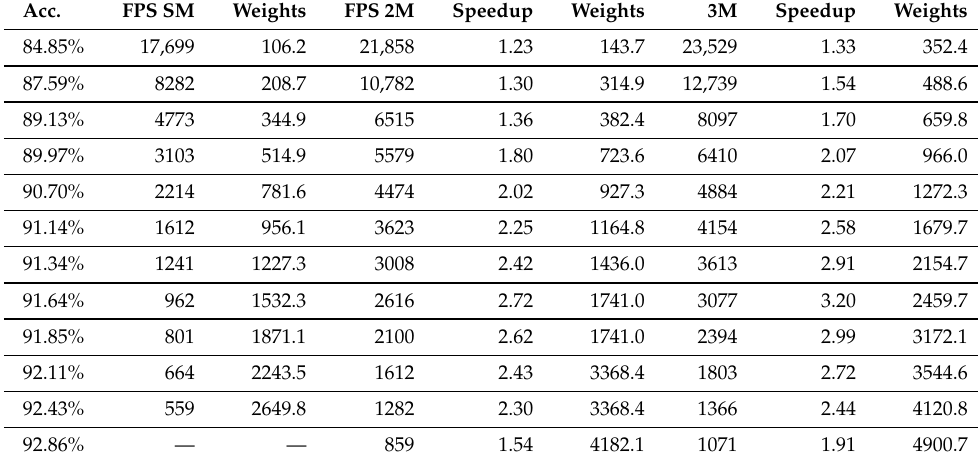
Table 3. Speedup achieved with incremental inference against inference with a single model. The results include the number of frames per second (FPS), total size of weights in KB, and the speedup compared to the solution of a single